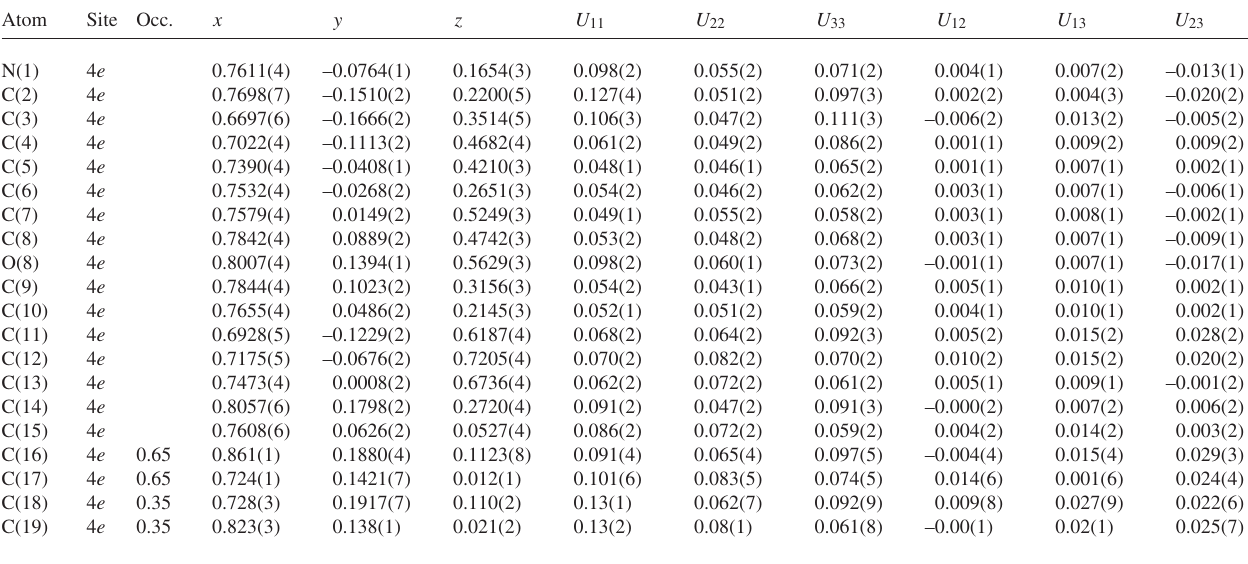
Table 3. Atomic coordinates and displacement parameters (in Å 2 ) . Atom Site